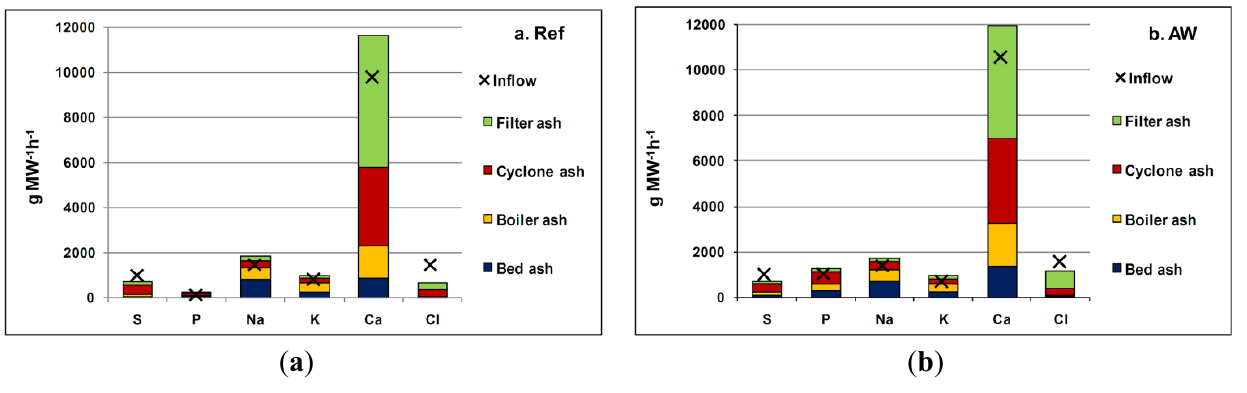
Figure 11. Element balances over the boiler: ( a ) Ref case; ( b ) AW case. X = The